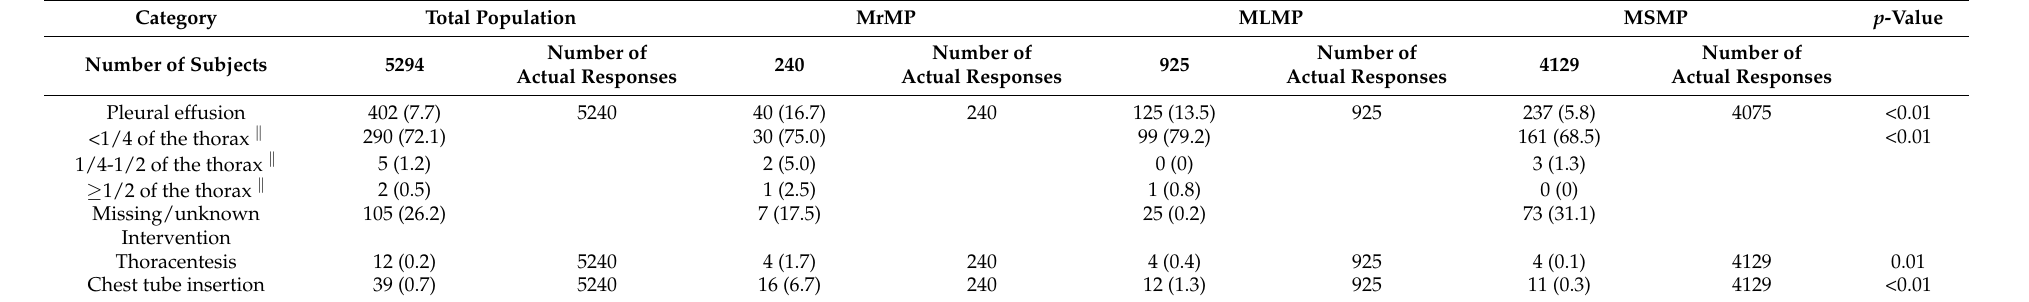
Table 5. Pleural effusion in Mycoplasma pneumoniae pneumonia and interventional